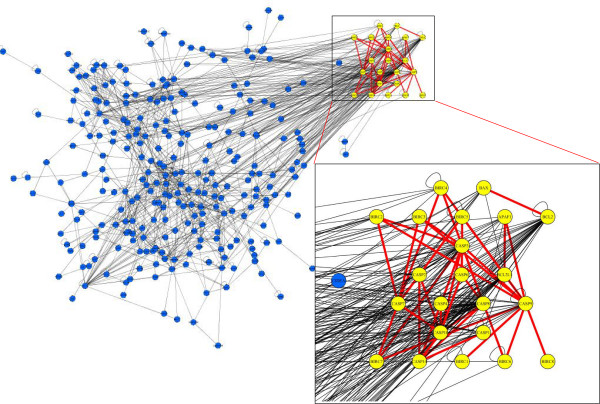
The most evolutionarily conserved interactions in AM.